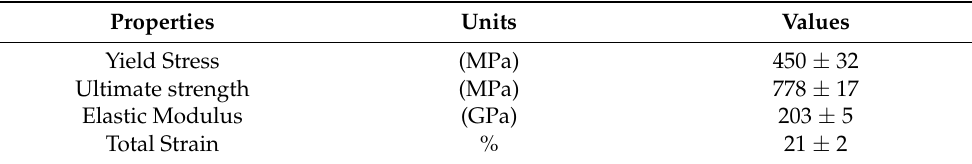
Table 2. Mechanical characteristics of HSLA steel, reprinted with permission from ref. [39]. Copyright 2018 Elsevier